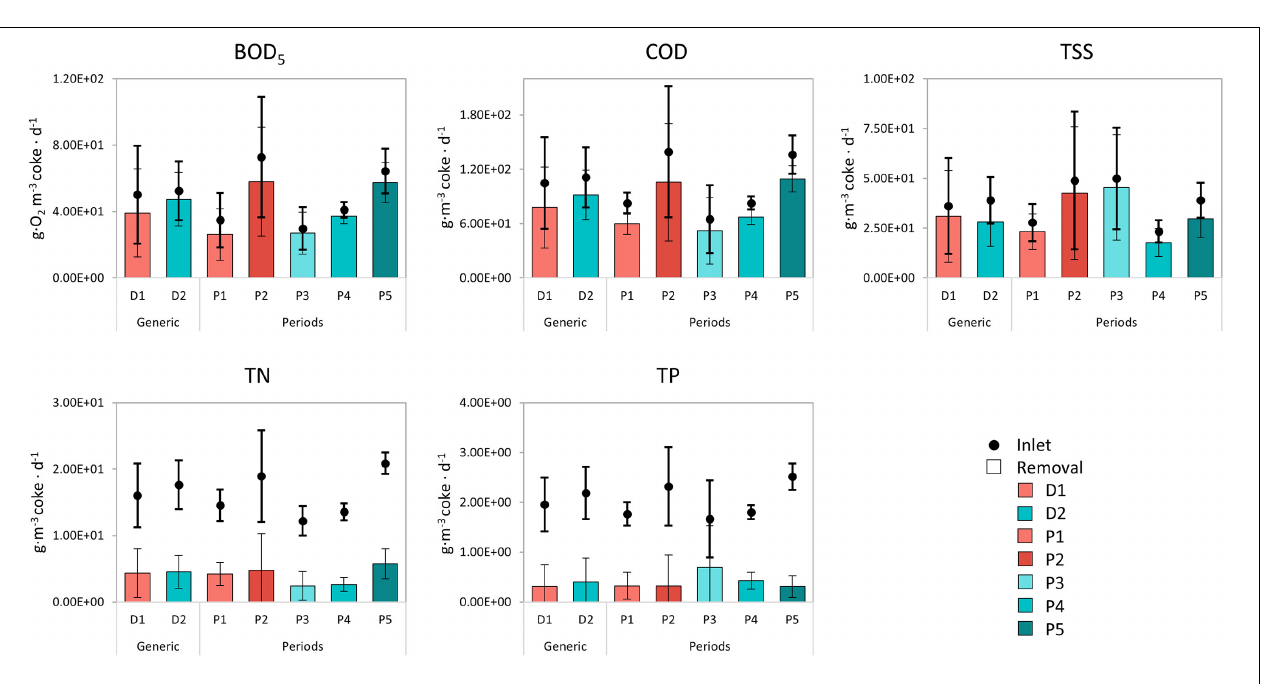
FIGURE 4 | Pollutant removal rates normalized per cubic meter of bed material for both designs (D1 and D2) and five periods (P1–P5). The data correspond to the METland R (cid:13) unit itself (without considering the primary treatment). Columns so-called generic were calculated as the average of different periods. Error bars represent the standard